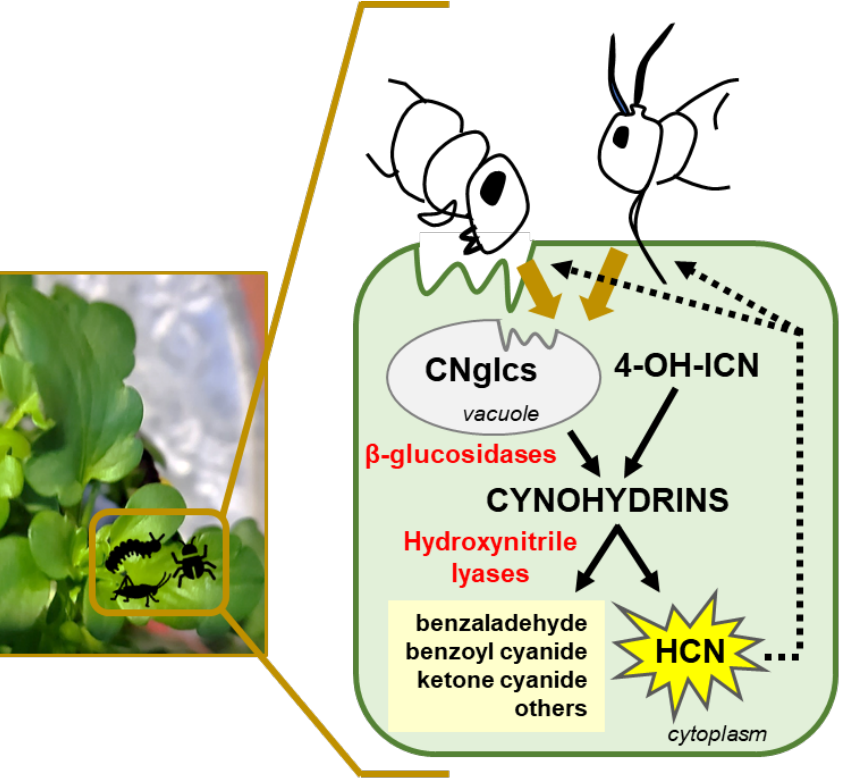
Figure 4. Cyanogenesis events in plant defence against pests. Insect and acari feeding on plants disrupt cells bringing in contact substrates (CNglcs: cyanogenic glucosides and 4-OH-ICN: 4-OH- Indolecarbonyl-nitrile derivatives) and enzymes ( β -glucosidases and hydroxynitrile lyases). Conse- quently, HCN is released , and aldehyde - or ketone - compounds are produced to combat pests.